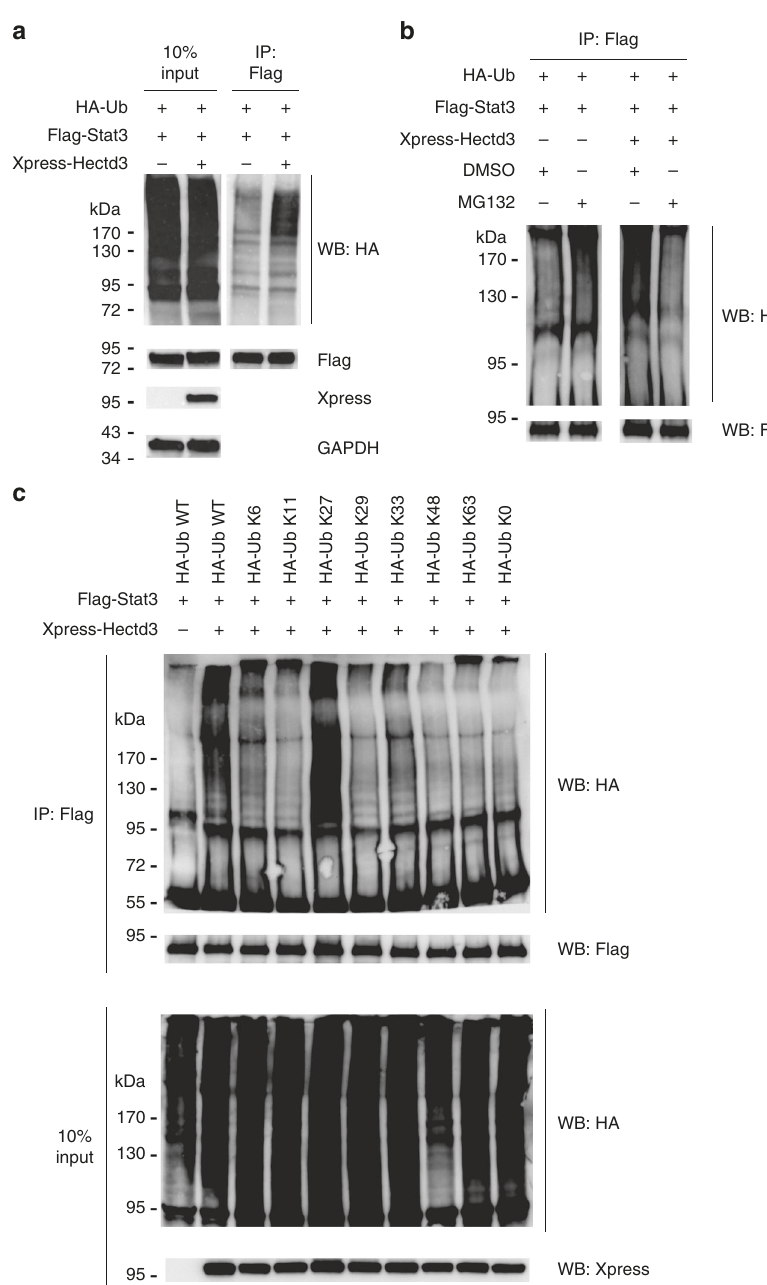
Fig. 8 Hectd3 promotes non-degradative K27-linked polyubiquitin chains on Stat3. a Immunoblot of HA, Flag, Xpress, and GAPDH following Flag immunoprecipitation of protein extracts from HEK293T cells co-transfected as indicated with HA-Ub, Flag-Stat3, and Xpress-Hectd3. b Immunoblot of HA and Flag following immunoprecipitation of protein extracts from HEK293T cells co-transfected as indicated with HA-Ub, Flag-Stat3, and Xpress-Hectd3 vectors and treated for 4 h with 20 μ M MG132 prior to protein extraction. c Immunoblot of HA and Flag following two-step Flag immunoprecipitation of protein extracts from HEK293T cells co-transfected with the indicated HA-Ub K only mutants, Flag-Stat3, and Xpress-Hectd3. HA-Ub K only mutants denote that the only lysine in the HA-tagged ubiquitin is at the indicated residue, and all other lysine residues are mutated to arginine. HA-Ub K0 mutant has all seven lysine residues mutated to arginine. a – c Immunoblots are representative of three independent experiments. Source data are provided